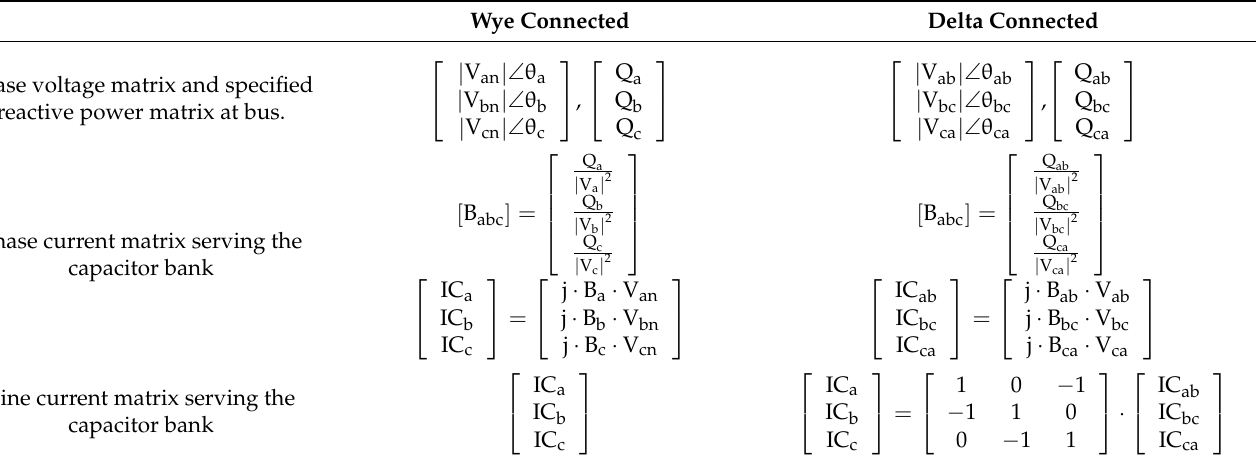
Table 2. Capacitor banks